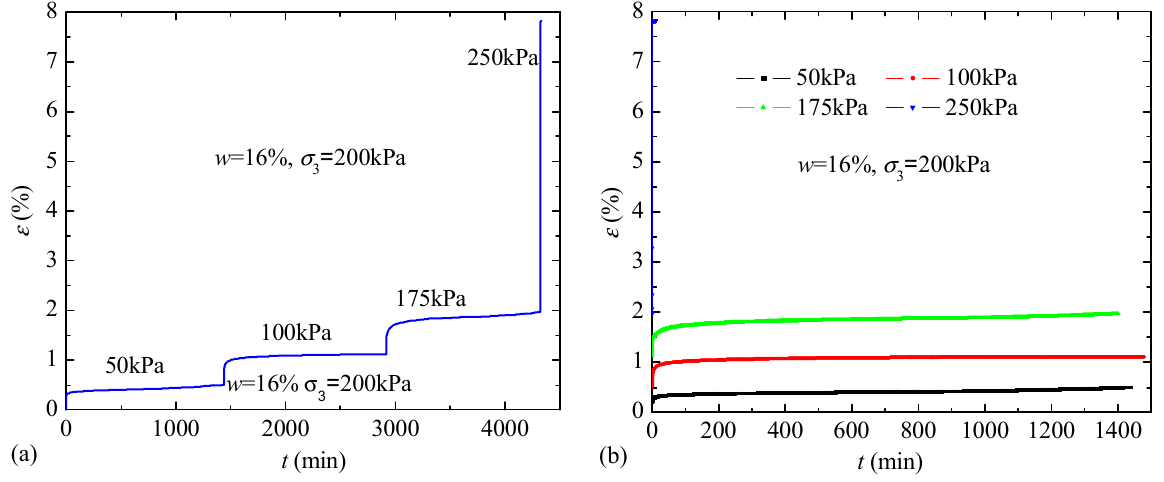
Figure 9. ( a ) The whole process curve of creep for loess with 20 dry-wet cycles, ( b ) creep curves of loess with 20 dry-wet cycles.